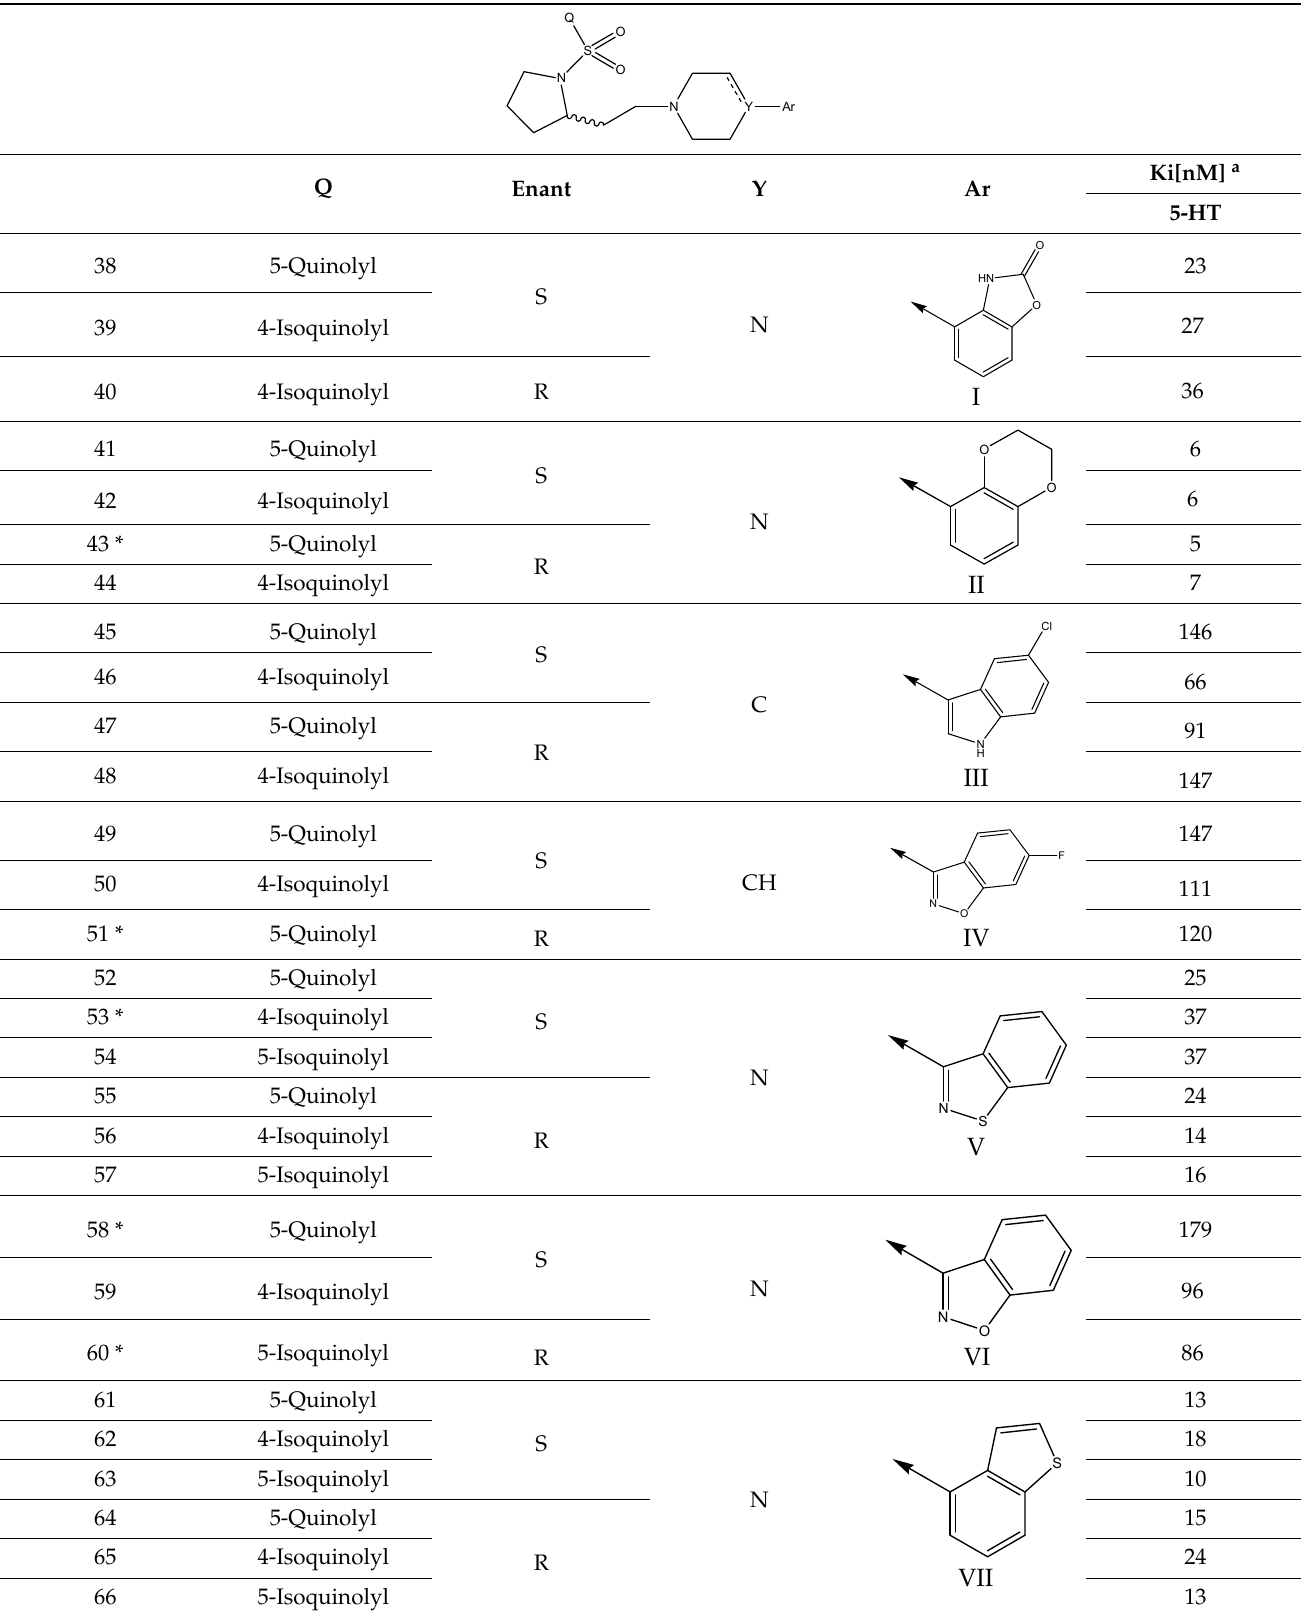
Figure 2. The predicted and the experimental pKi values (nM) of CoMSIA model. Table 1. Structures of the azinesulfonamides of cyclic amine derivatives and Ki values.